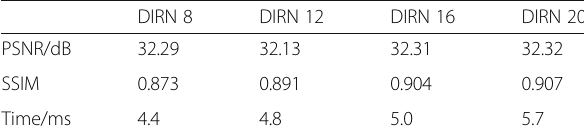
Table 1 The average PSNR (dB), SSIM, and run time (ms) under different network depth